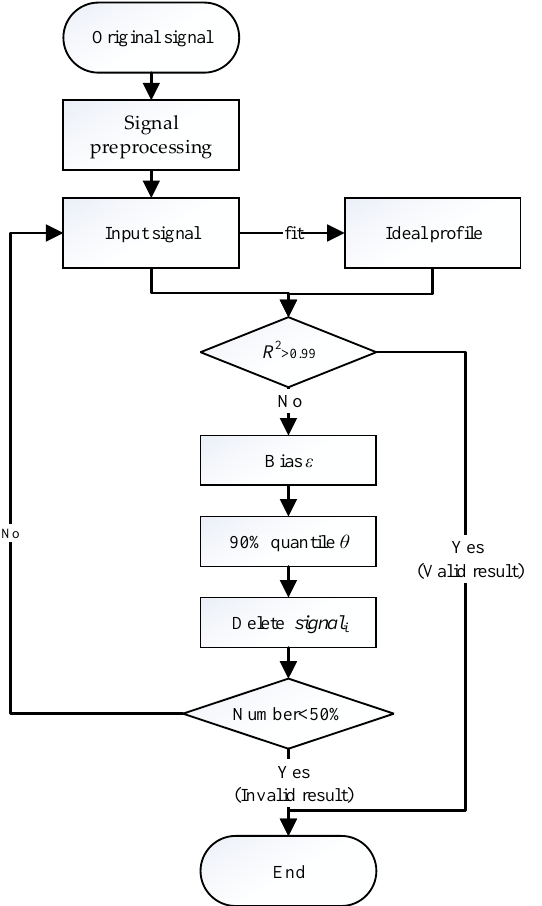
Figure 1. Flowchart of the improved iterative fitting method to determine residual layer height (RLH) from Lidar signal.